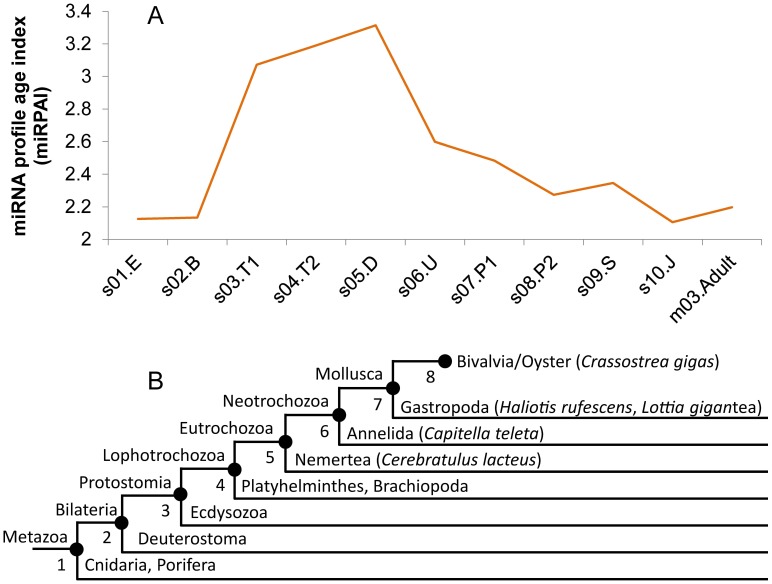
The miRPAI curve during oyster development.
A. The miRPAIs for the 11 development stages were calculated by integrating the evolutionary acquisition (phylostrata) and the expression level of each miRNA (see the method part for details). Higher miRPAI indicates more expression of younger miRNAs in the stage. The samples are abbreviated as follows: s01.E, egg; s02.B, blastula; s03.T1, trochophore; s04.T2, trochophore; s05.D, D-shape larva; s06.U, umbo larva; s07.P1, pediveliger larva; s08.P2, pediveliger larva; s09.S, spat; s10.J, juvenile; and m03.Adult, mixture of tissues from an adult. B. The taxonomic nomenclature of the phylostrata analyses.